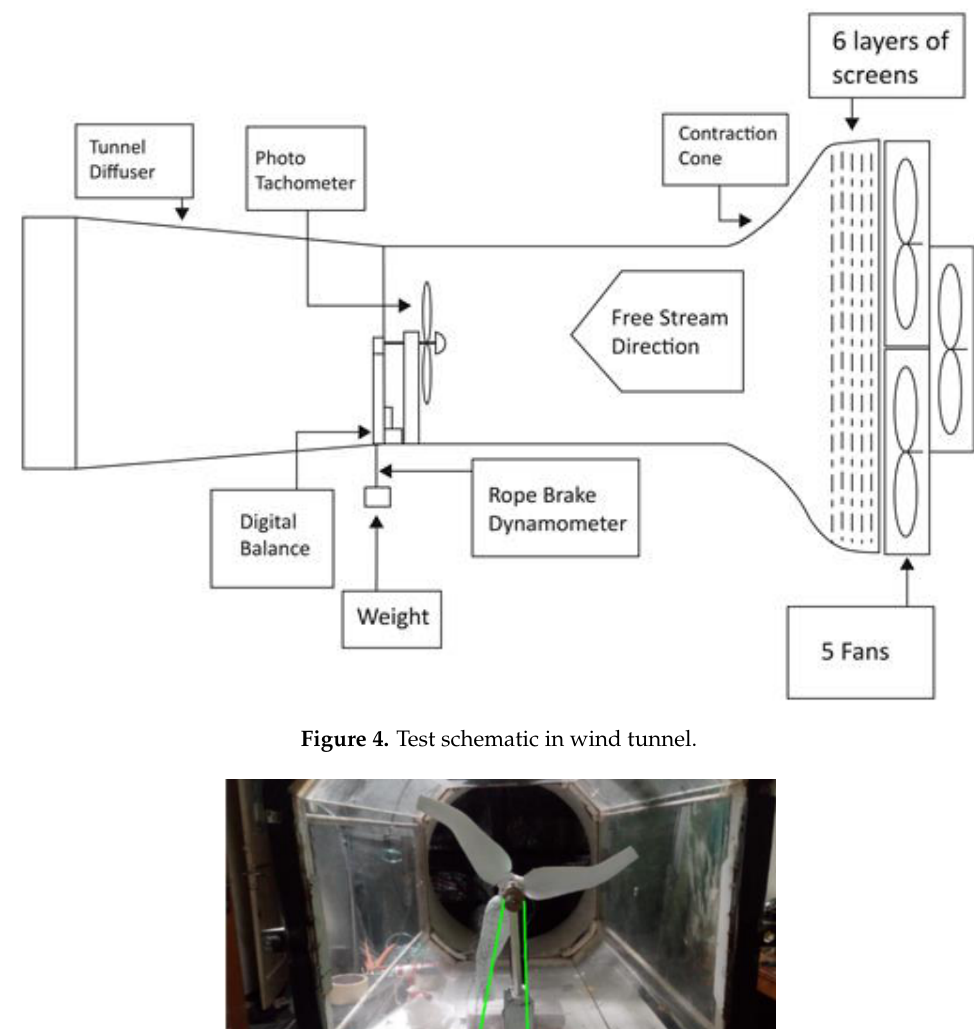
Figure 5. Measurement setup in wind tunnel 167